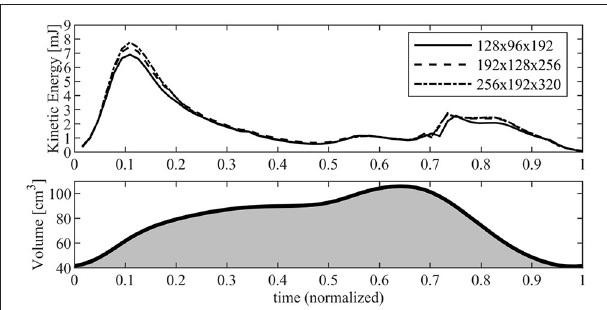
FIGURE 2 | Kinetic energy inside the right ventricle (RV) evaluated with different numerical resolution. The continuous line corresponds to a grid made up of 128 × 96 × 192 points; dashed line corresponds to a grid made up of 192 × 128 × 256 points; dash-dot line corresponds to a grid made up of 256 × 192 × 320 points. The RV volume curve is reported below for reference.